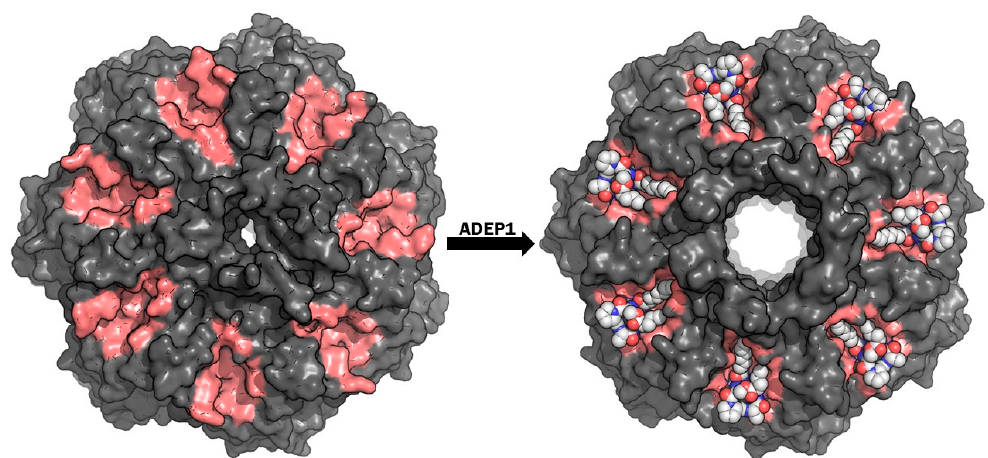
Figure 4. Top view of E. coli ClpP in unbound state ( left ) (PDB ID: 1YG6) and bound with acyldepsipeptide (ADEP)1 ( right ) (PDB ID: 3MT6). When bound, an increase in pore size can be observed which defines an active, non-selective conformation. The protein is shown in grey surface representation, with the ADEP1 binding pockets shown in pink. ADEP1 molecules are represented by white spheres.